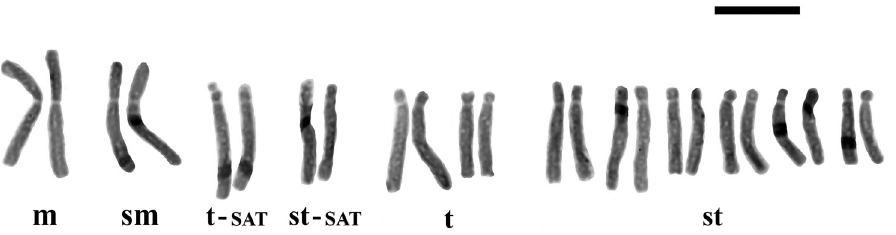
Figure 6. Karyogram of Fritillaria epirotica from Mt. Smolikas, 2n = 2x = 24. Bar =10